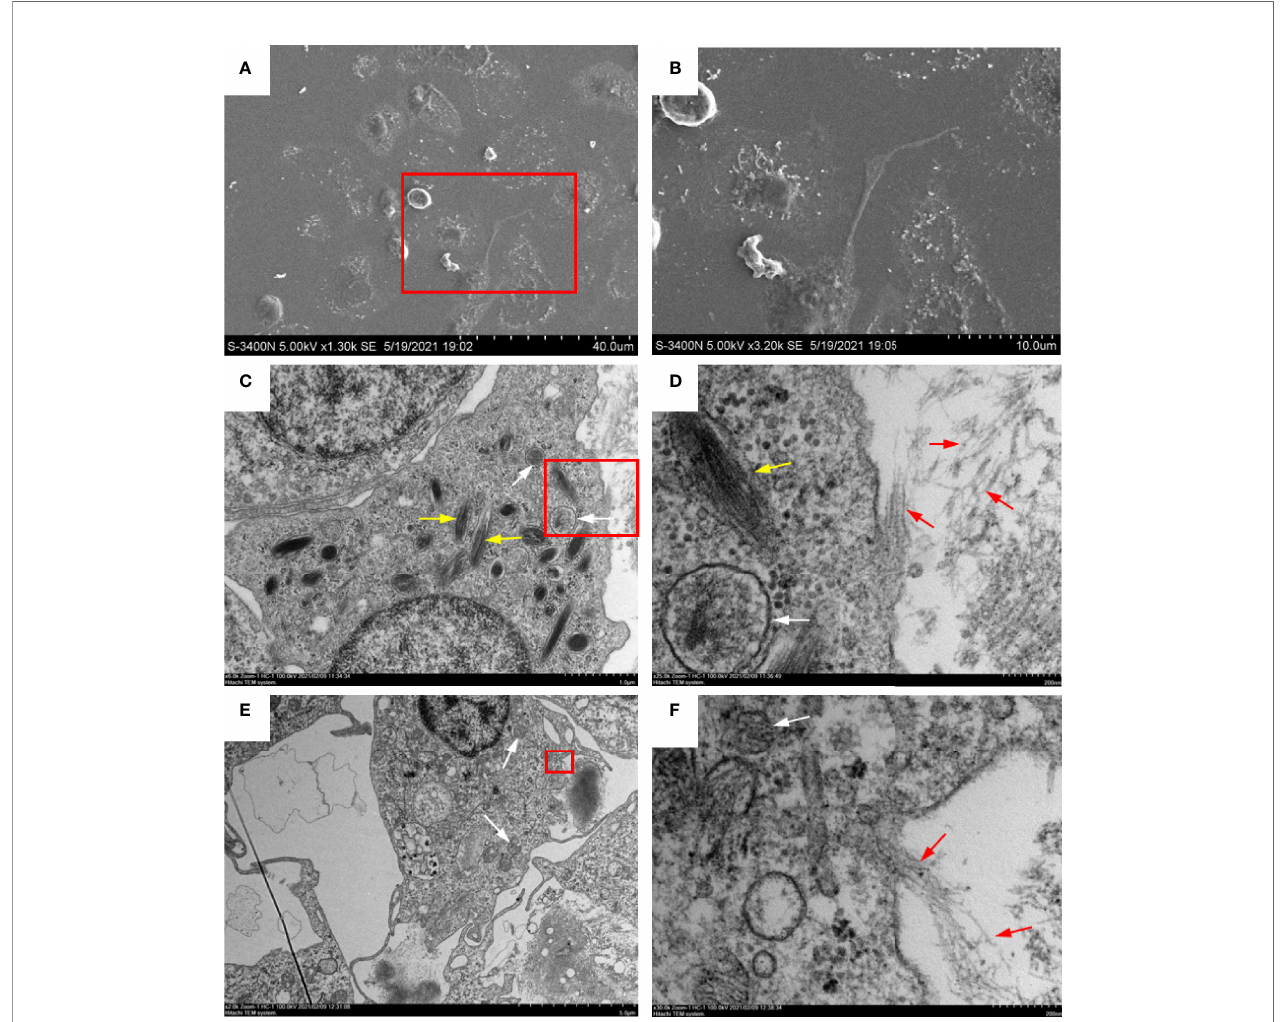
FIGURE 3 | Ultrastructural observation of extracellular trap (ET) release from peritoneal cells in response to ovalbumin (OVA)/Alum stimulation. (A, B) Scanning electron microscopy showed that long stretches of fi bers were released from peritoneal cells. (C, D) Transmission electron microscopy of ETs releasing neutrophil- like cells. (E, F) Transmission electron microscopy of ETs releasing macrophage-like cells. (B , D, F) Magni fi ed images of the boxed regions in (A , C , E ) respectively. White arrows indicate mitochondria, yellow arrows indicate fusiform peroxisomes, and red arrows show DNA fi bers released from a pore in the cell